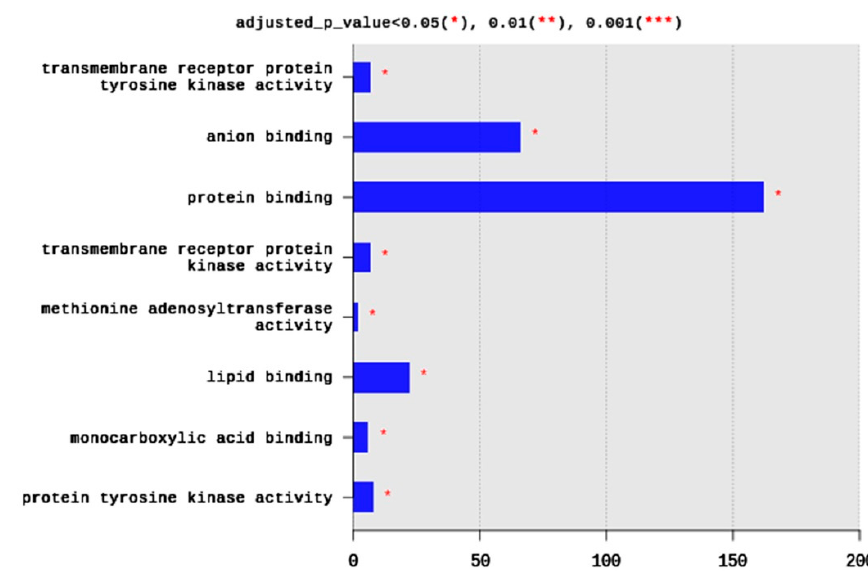
Figure 4. Distribution of GO top 10 enriched molecular functions (MF) terms, adjusted p < 0.05. The Y axis represents the enriched BP terms, X axis represents the intersection size (the number of DEGs for an MF term).